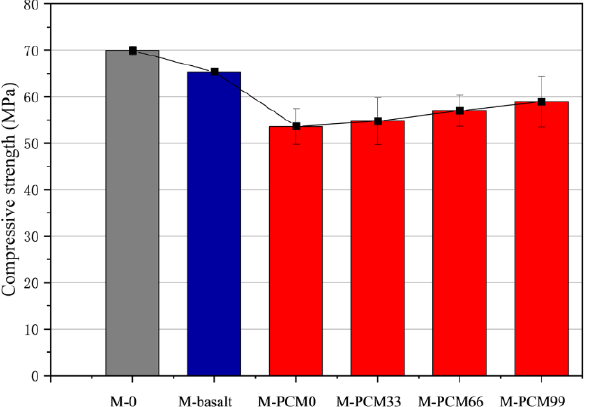
Figure 7. Compressive strength of cementitious composite samples for 28 days. (In the Figure the grey is pure mortar, the blue with basalt aggregate and the red with different phase change aggre- gates).